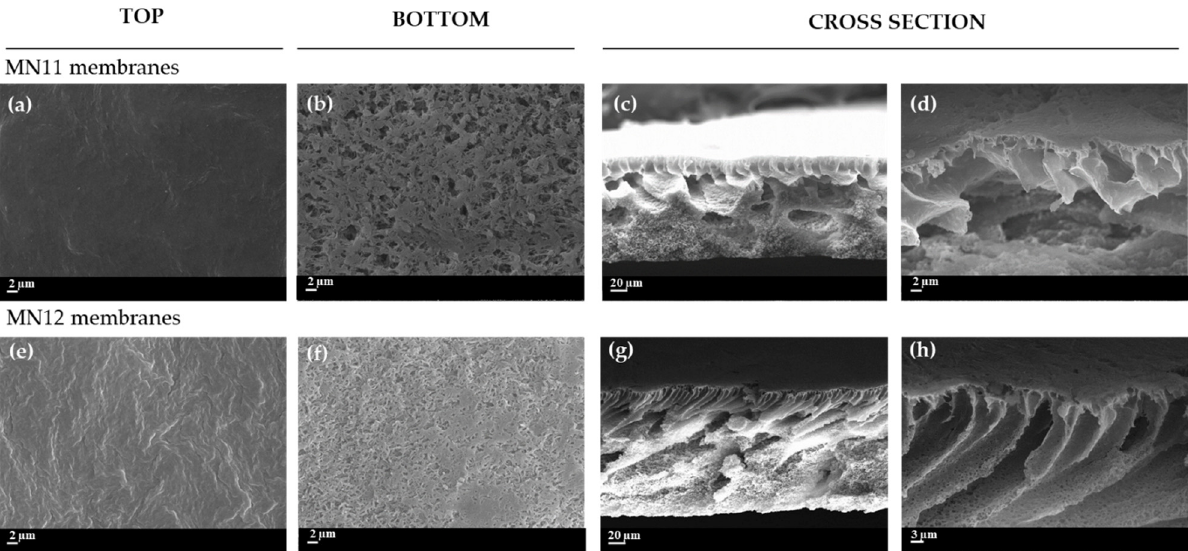
Figure 5. SEM image of prepared PVDF (10 wt%) membranes: ( a – d ) surface (top and bottom Mag. 5.00 KX) and cross-section (Mag. 800 X and 5.00 KX) of MN11 with PEG 200 (20 wt%) and ( e – h ) surface (top and bottom Mag. 5.00 KX) and cross-section (Mag. 800 X and 5.00 KX) of MN12 with PEG 200 (20 wt%) and PVP K17 (5 wt%).